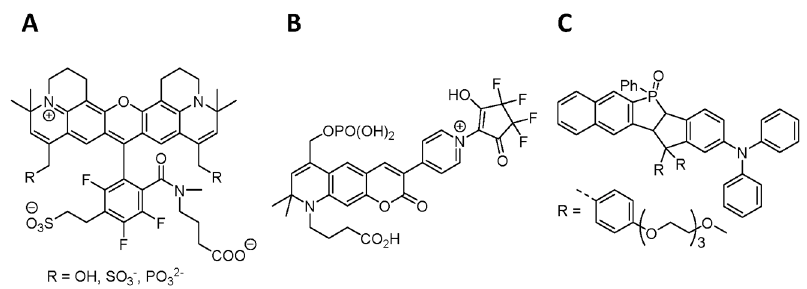
Figure 16. Optimized fluorophores for STED nanoscopy. ( A ) Rhodamine; ( B ) Coumarin; ( C ) Phosphole P -oxide.